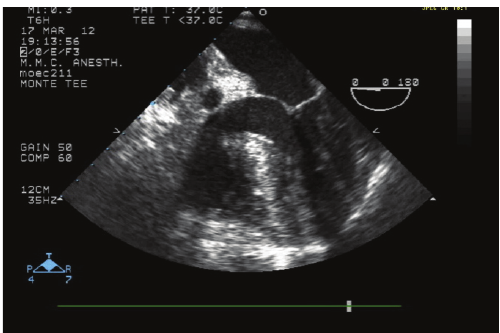
Figure 1: Transesophageal echocardiogram showing thrombus in the left